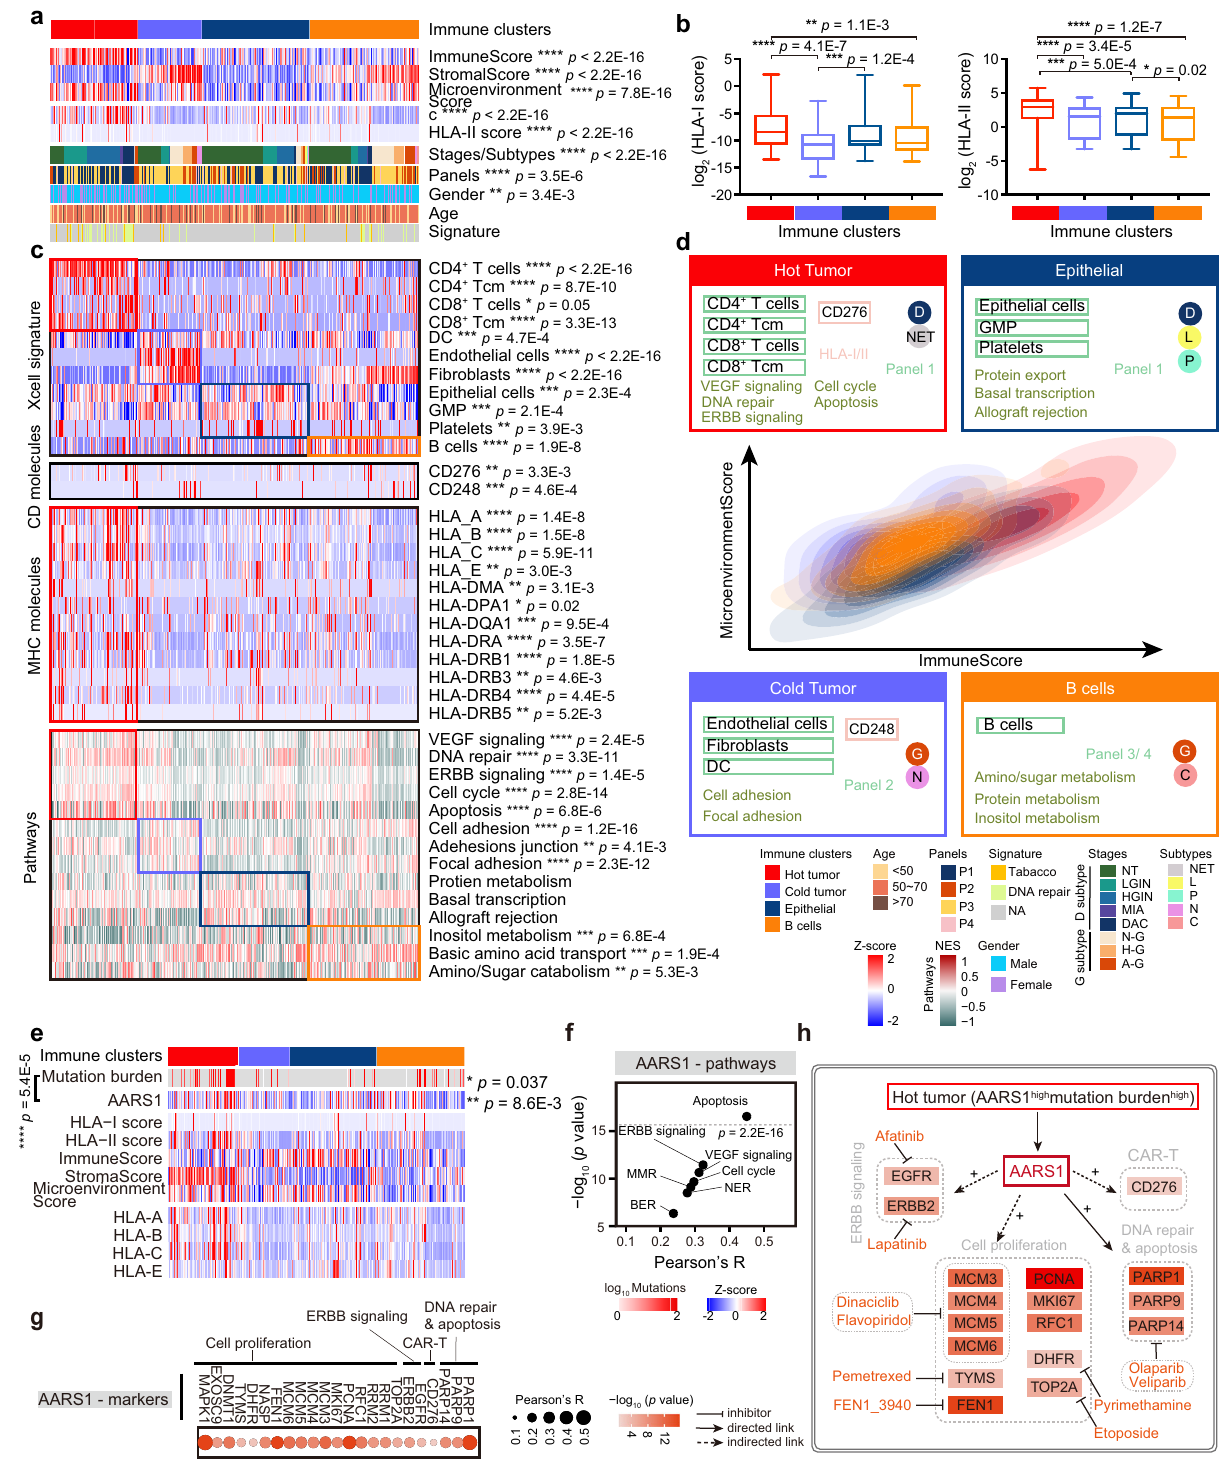
inhibitor directed link indirected